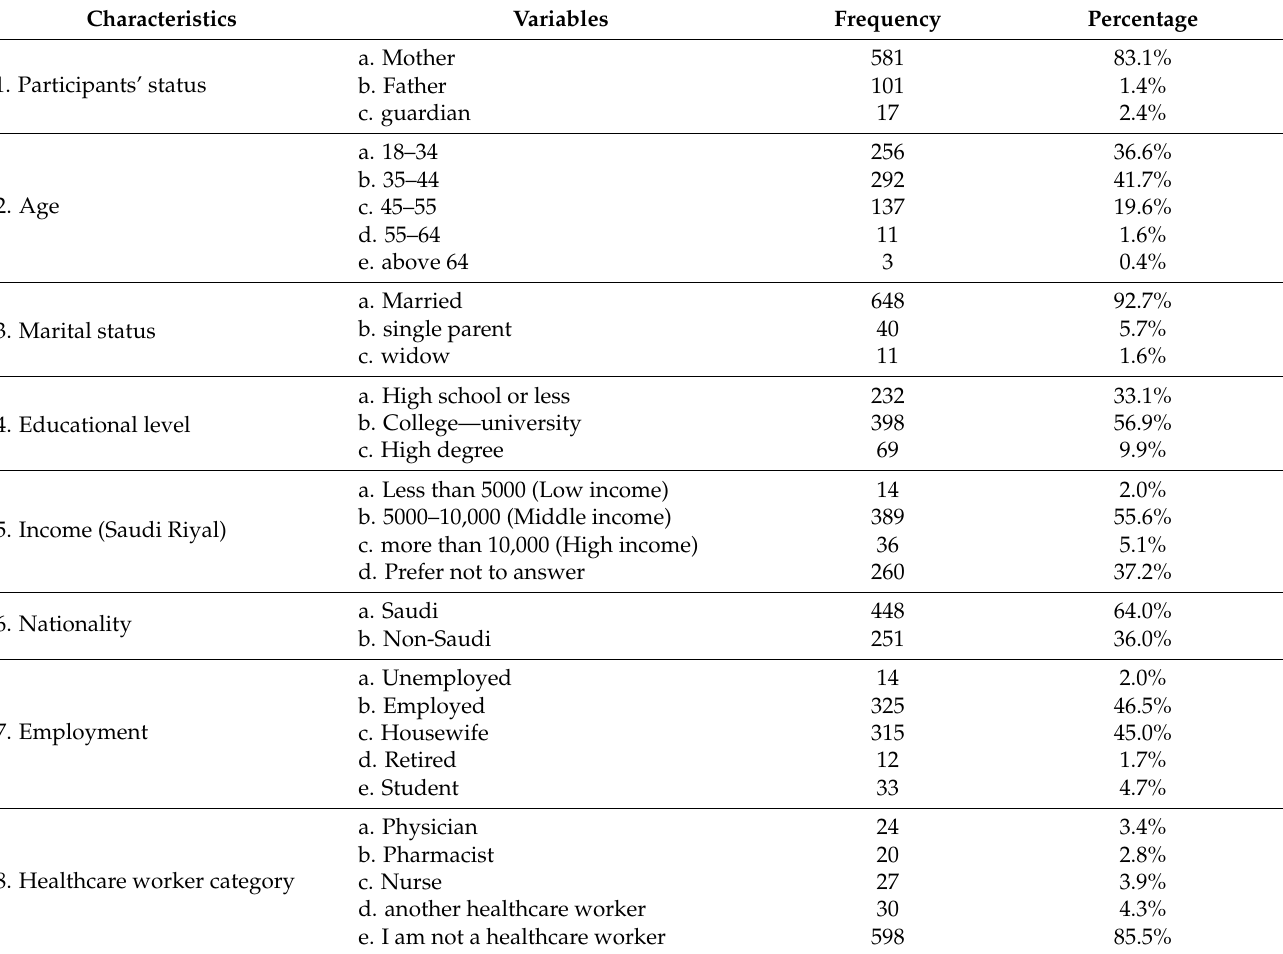
Table 1. Sociodemographic characteristics.